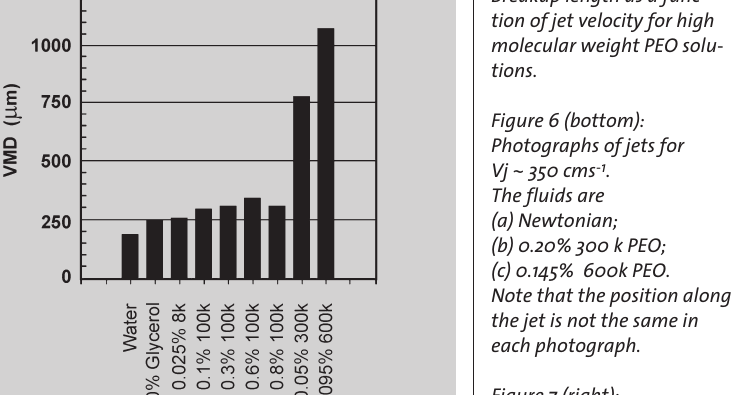
Figure 5 (left): Breakup length as a func- tion of jet velocity for high molecular weight PEO solu- tions. Figure 6 (bottom): Photographs of jets for Vj ~ 350 cms -1 . The fluids are (a) Newtonian; (b) 0.20% 300 k PEO; (c) 0.145% 600k PEO. Note that the position along the jet is not the same in each photograph. Figure 7 (right): Volumetric mean diameter, VMD, of drops produced for the test fluids atomised in a TG-SS Full